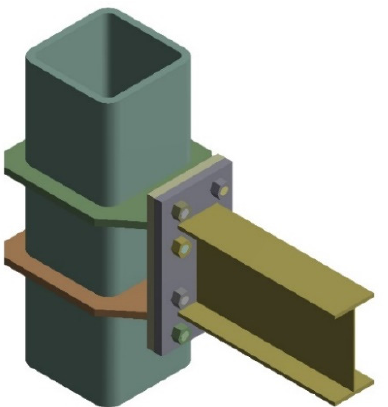
Figure 2. View of End Plate to Hollow Structural Section (EP-HSS) moment connection.